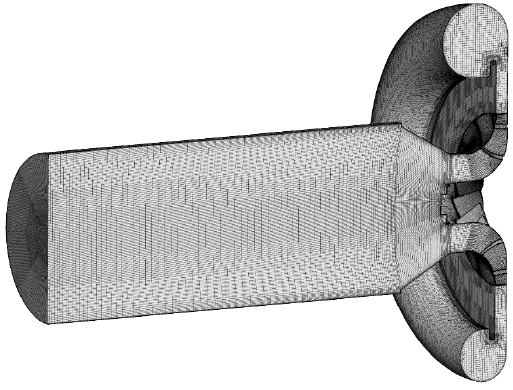
Figure 12. Grid model of the compressor flow path.